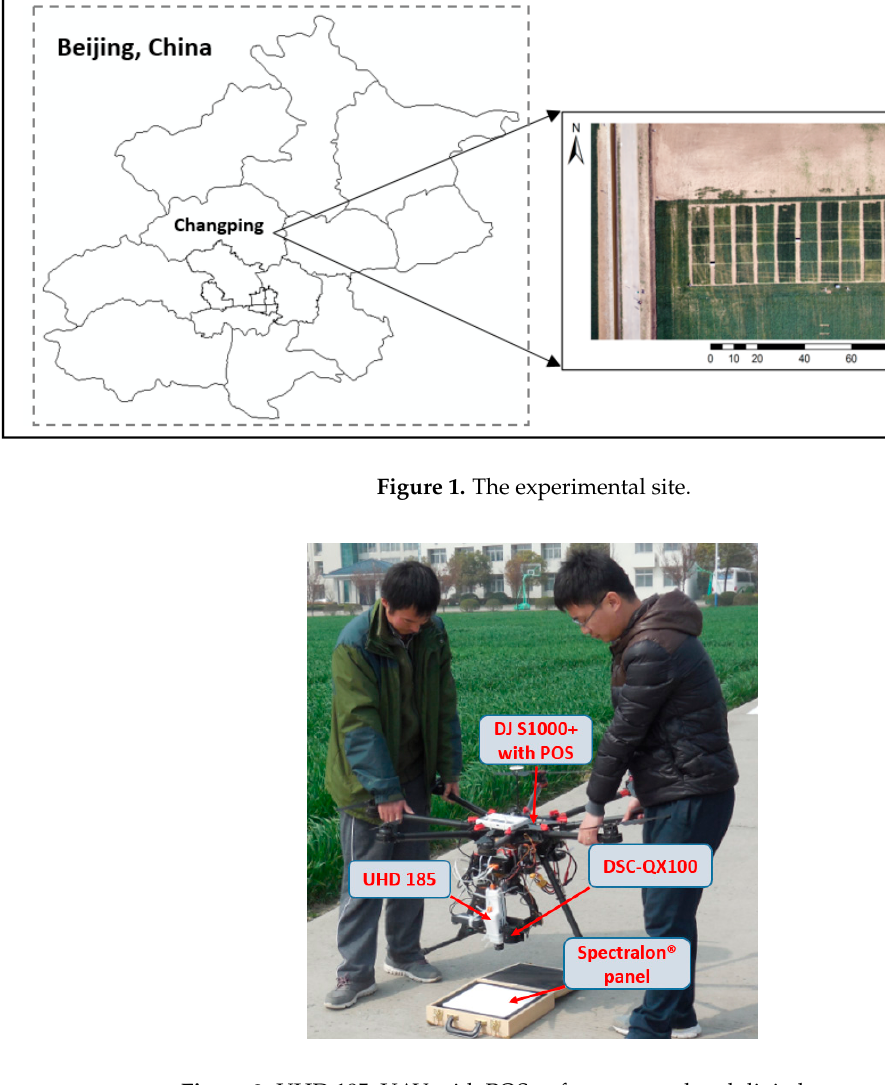
Figure 2. UHD 185, UAV with POS, reference panel and digital camera.